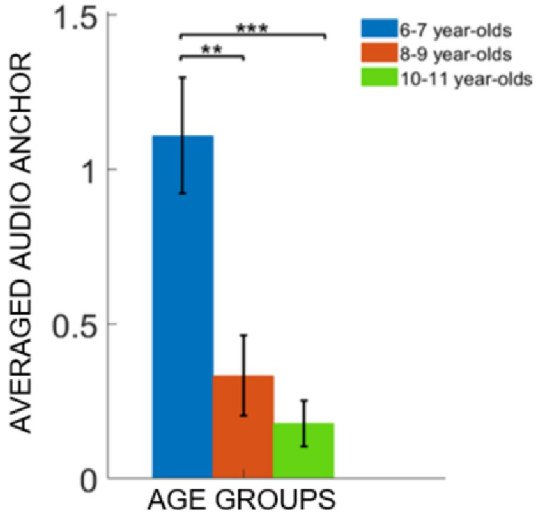
Fig 2. Audio-anchor. Data are presented as the mean across participants per each group; error bars represent the standard error. Regardless of the condition, 6–7 year-olds used the Audio-anchor exploration strategy more often compared to the other age groups. Significant comparisons between groups are represented. Two asterisks ( �� ) represent p < 0.01 and three asterisks ( ��� ) p < 0.001.